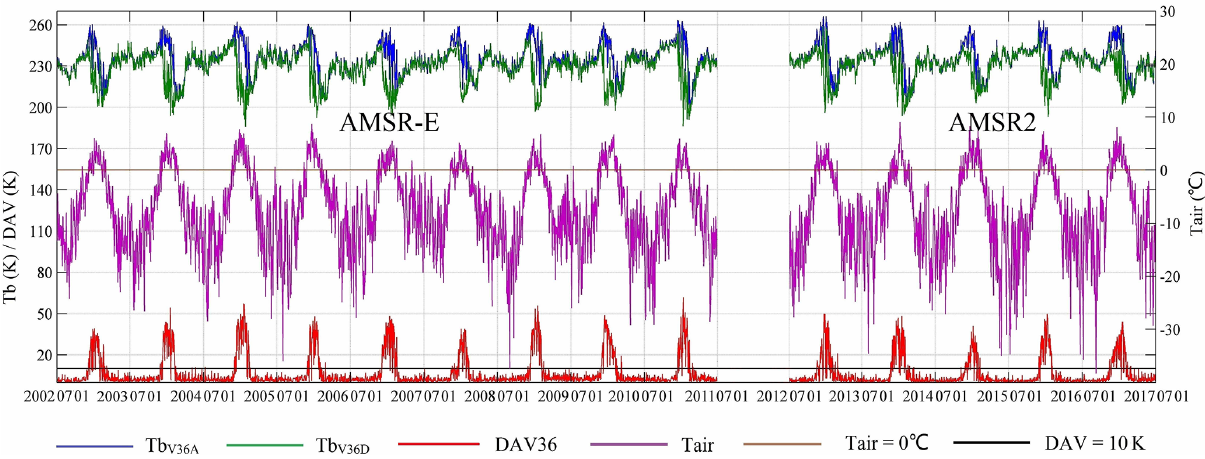
Figure 2. The comparison between T air and satellite observations (AMSR-E from 2002 to 2011 and AMSR2 from 2012 to 2017) at Zhong- shan Station, including daily maximum T air (purple line), T b black lines represent T air = 0 ◦ C and DAV =